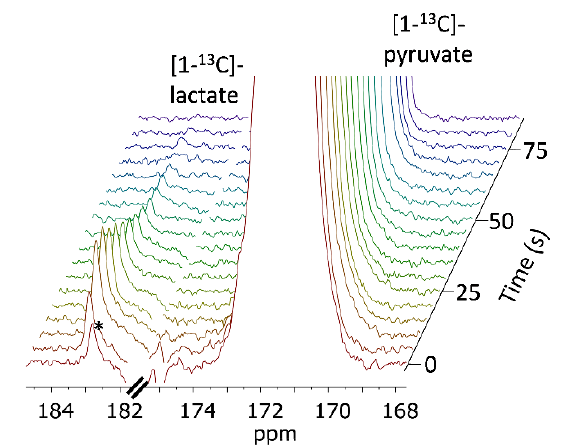
Figure 5. 13 C-NMR spectra of viable MCF7 tissue slices in the presence of 14 mM hyperpolarized